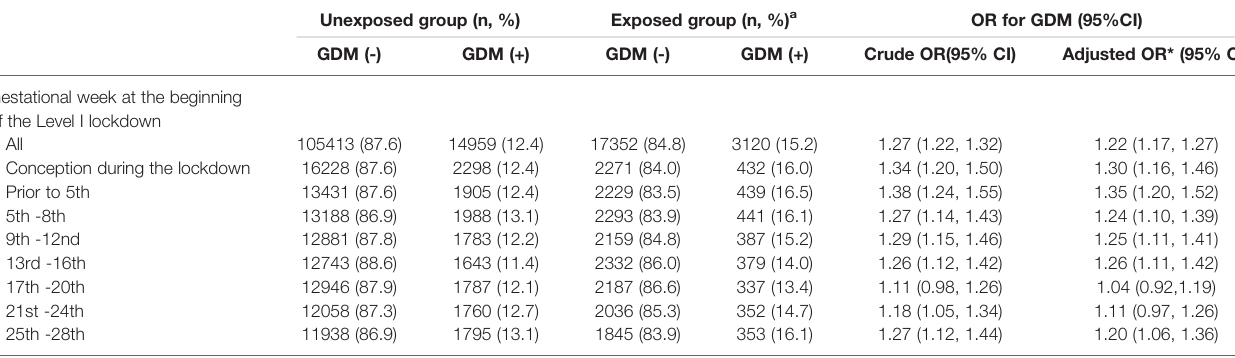
TABLE 2 | Associations of exposure to the COVID-19 lockdown with gestational diabetes mellitus. Unexposed group (n, %) Exposed group (n, %) a